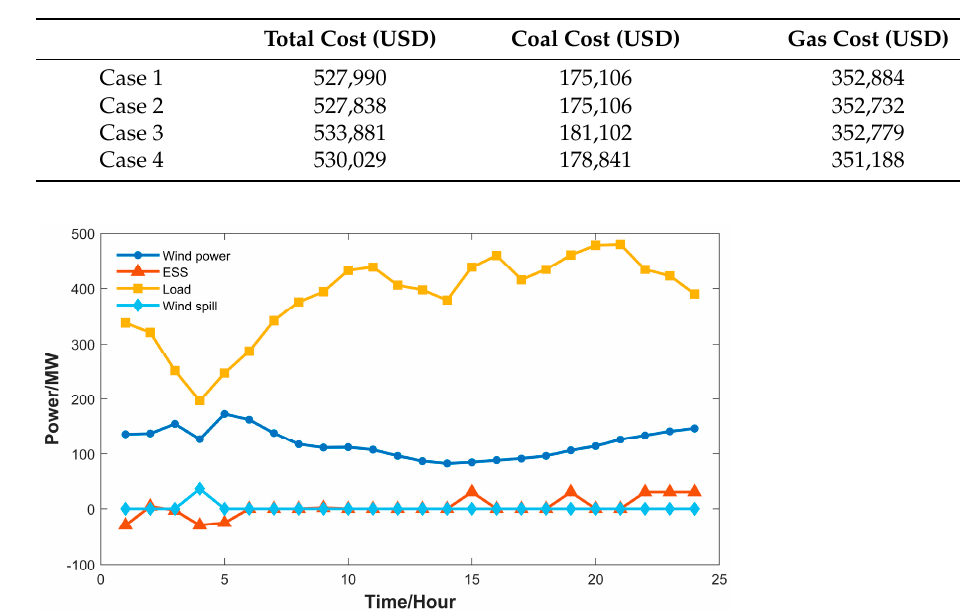
Table 4. System cost in different cases.